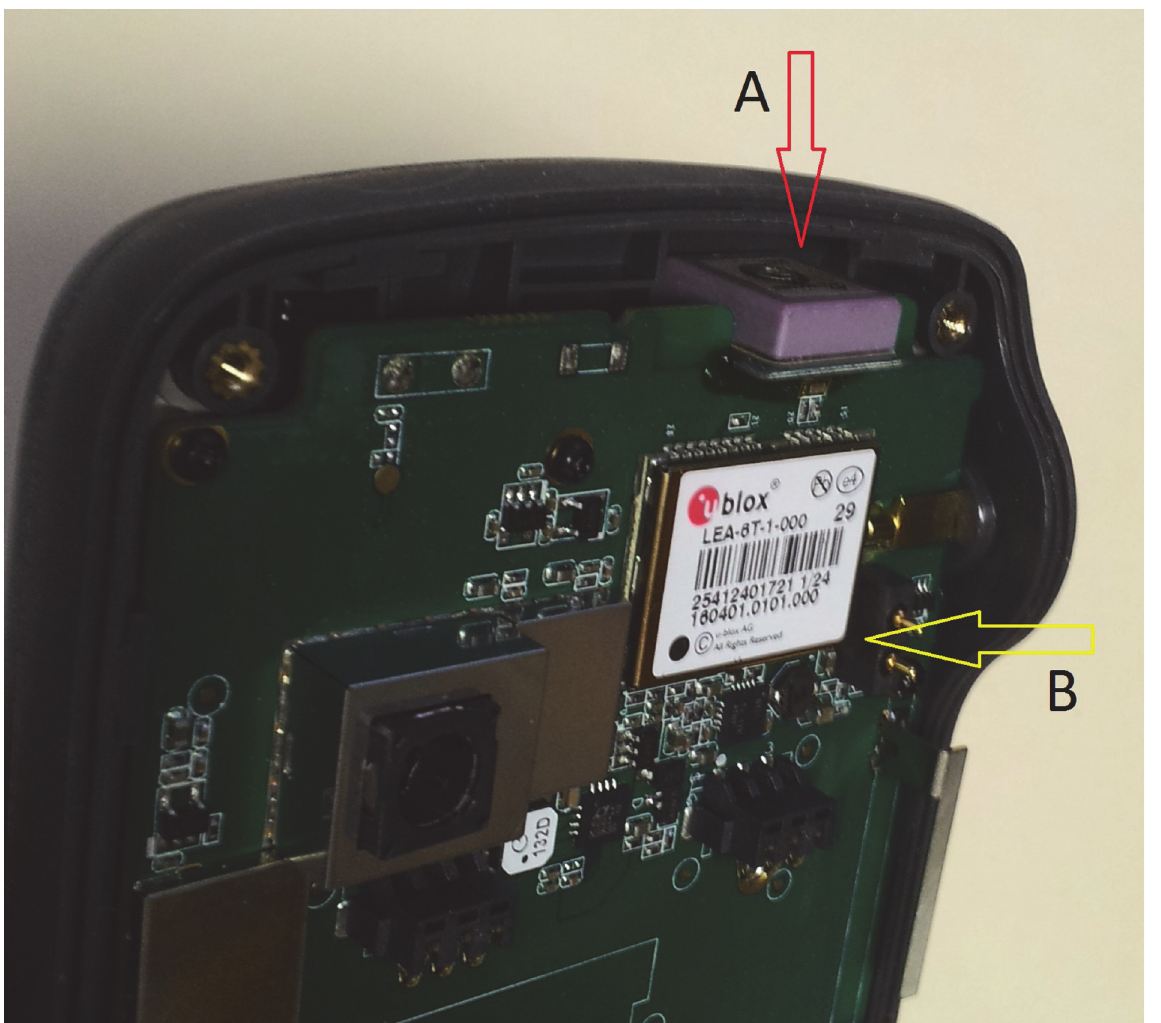
Fig 1. Cirocomm antenna (A) and u-blox receiver (B) within the Flint GNSS